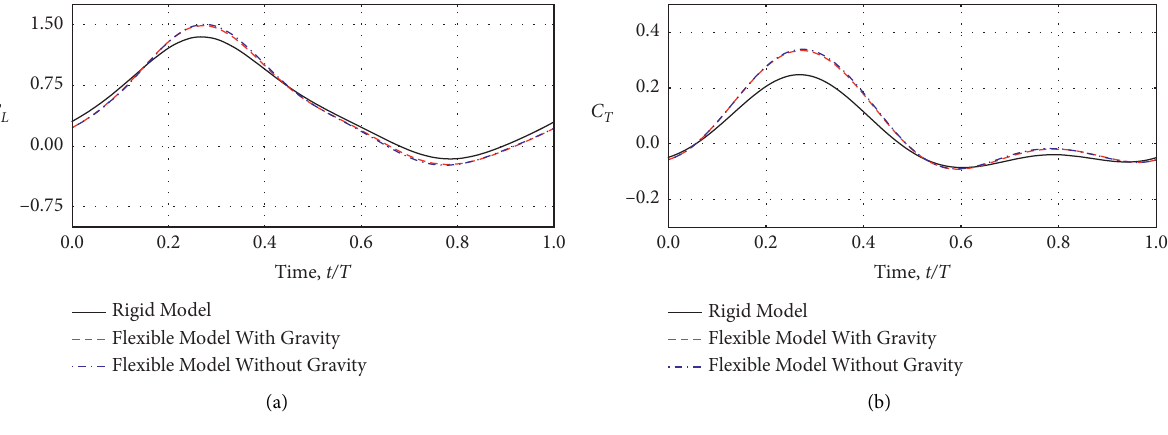
Figure 13: Lift coefficient and drag coefficient vs. time in a period.